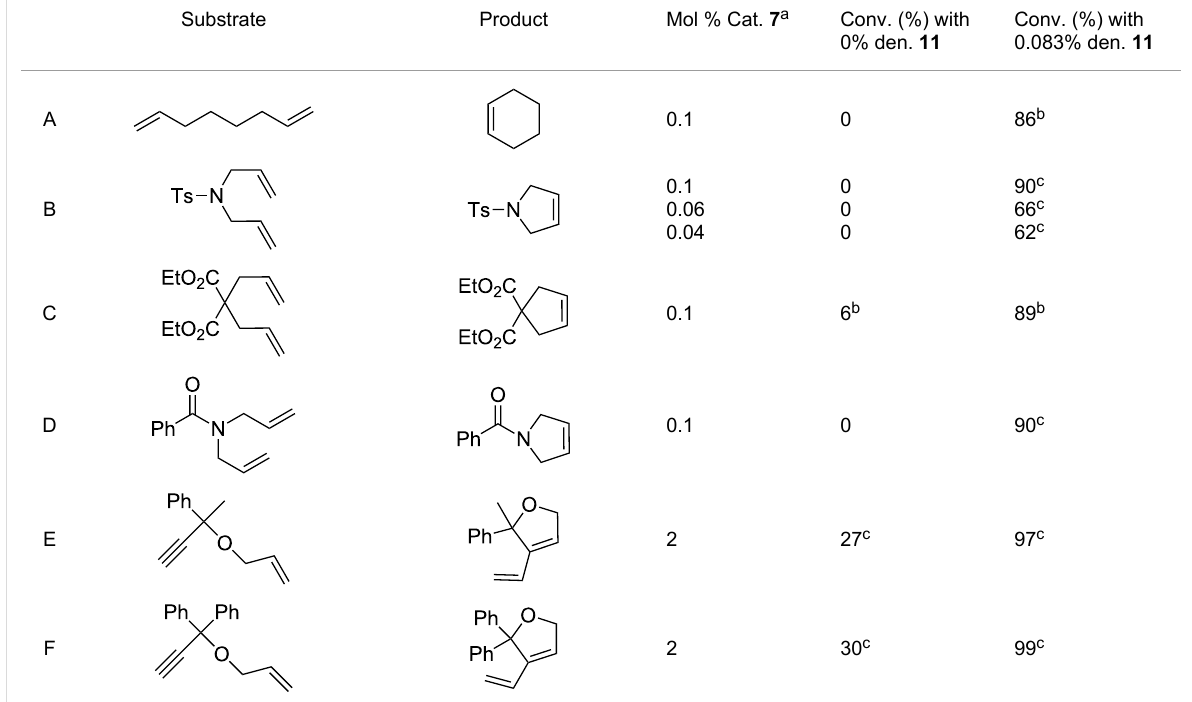
Table 1: Compared RCM and EYM catalyzed by 7 in water without co-solvent, in the presence and absence of dendrimer 11 . Substrate Product Mol % Cat. 7 a Conv. (%) with